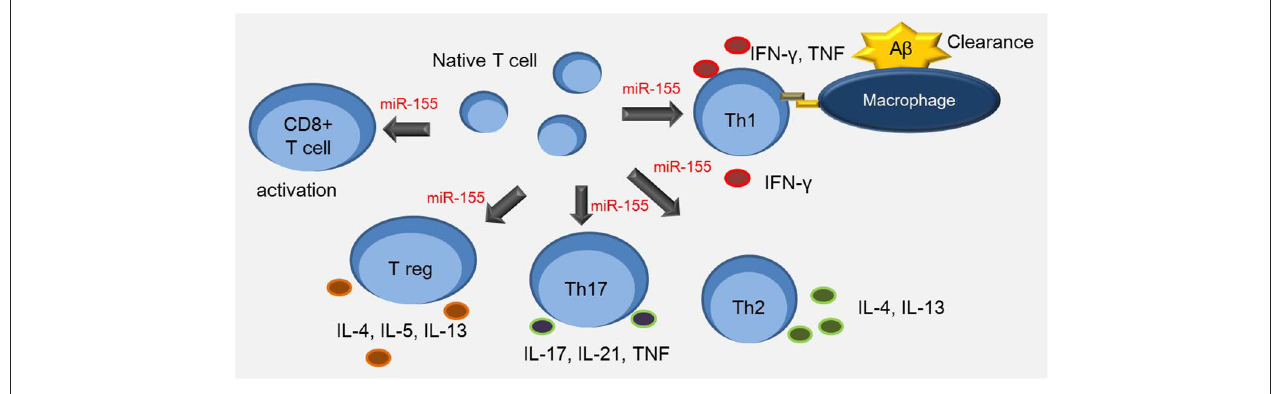
FIGURE 1 | miR-155 is involved in the T cell response . Th1 cells up-regulate expression of major histocompatibility complex (MHC) class II and CD86 in antigen presenting cells such as macrophages. A β -reactive Th1 cells increase the secretion of inflammatory cytokines such as IFN- γ